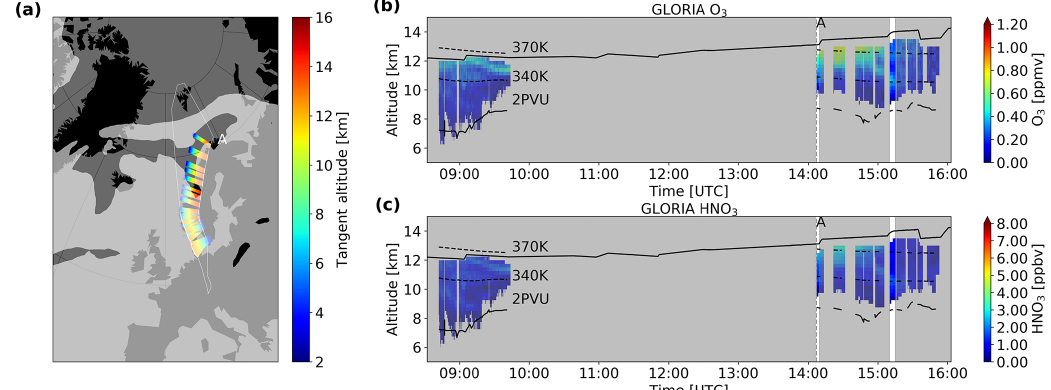
Figure A1. (a) Flight path and vortex filtering according to the Nash criterion at 370K for flight 5 on 21 December 2015. White line: flight track with characteristic waypoint (A); dark grey shading: areas that are associated with the polar vortex. Cross sections of (b) O 3 and (c) HNO 3 distribution derived from GLORIA. Flight altitude (bold black line), characteristic waypoint (A), 340 and 370K potential temperature levels (MERRA-2, dashed black lines), and 2PVU level (MERRA-2, black line). Passages attributed to non-sub-vortex air are shaded in grey.